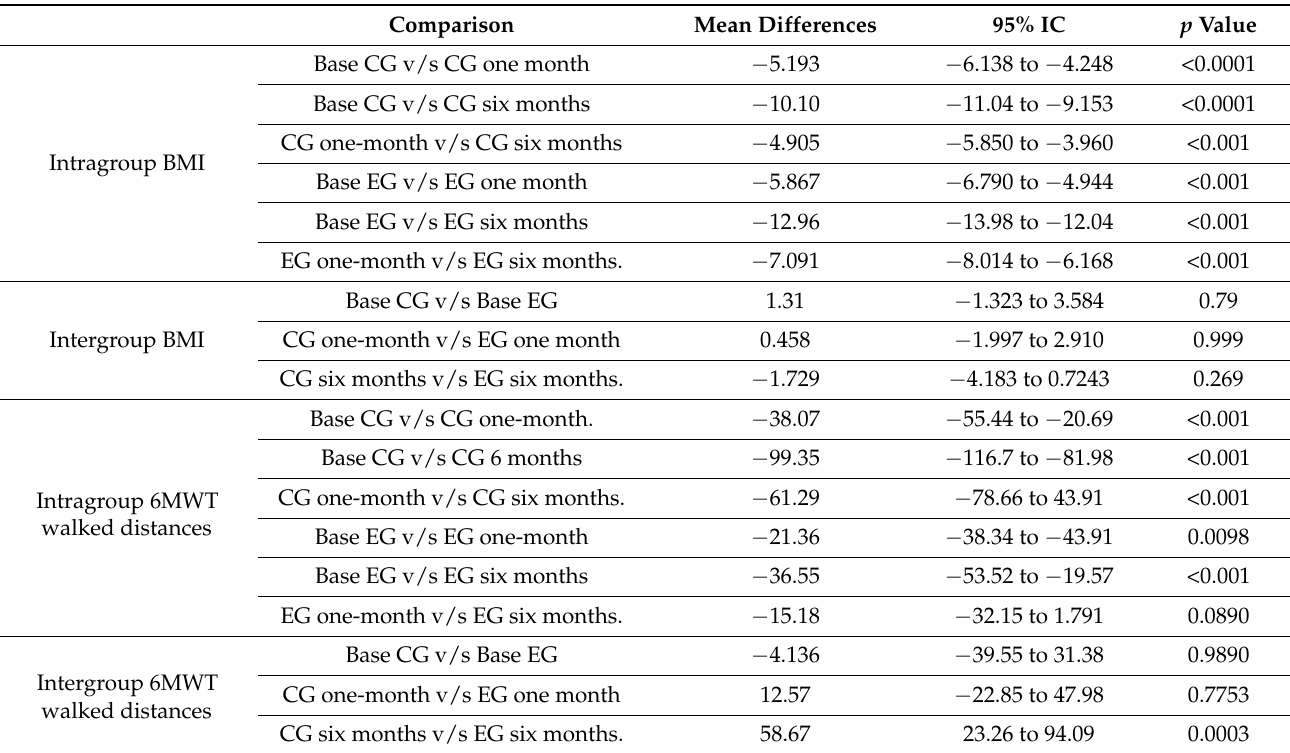
Table 3. Intragroup and Intergroup Multiple